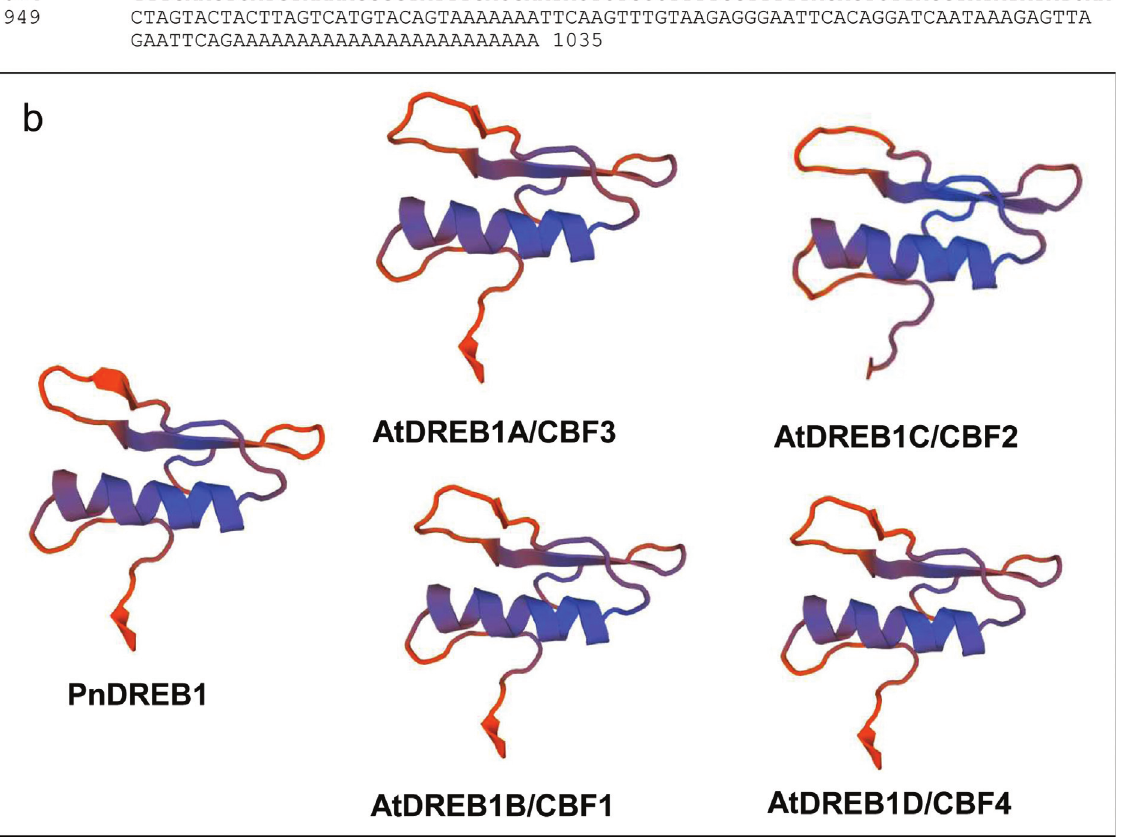
Figure1 -Sequencesof PnDREB1 (a)andcomparisonof3DstructuresoffourDREB1proteinsof Arabidopsis